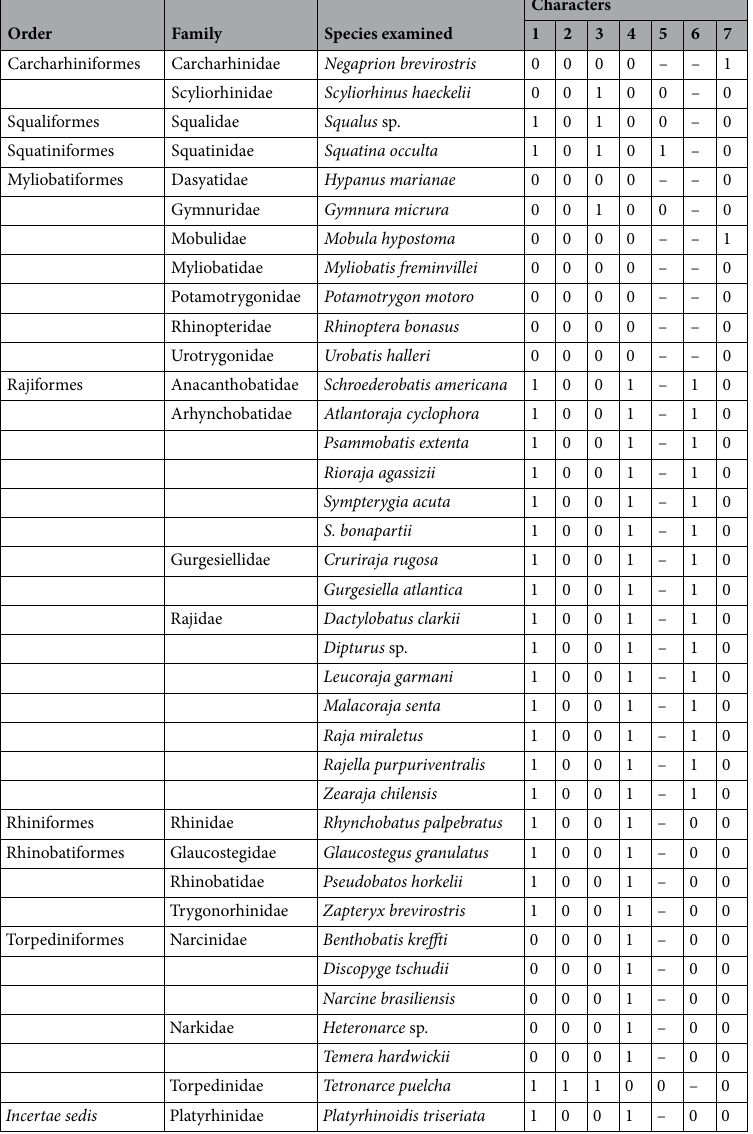
Table 1. List of batoid and shark species examined in the present study with respective character states from afferent branchial